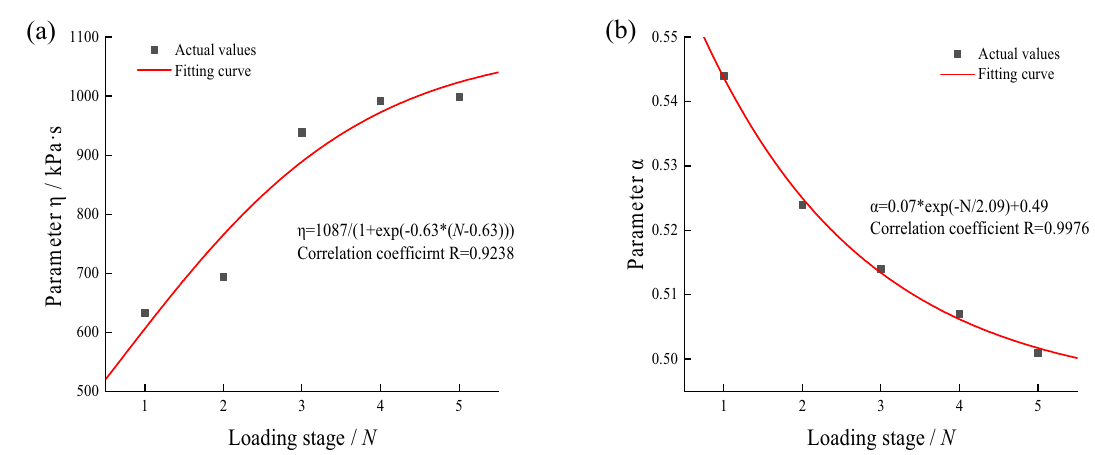
Figure 13. Fitting parameters of fine-grained soil under single-stage intermittent loading and its variation curve with loading stage.